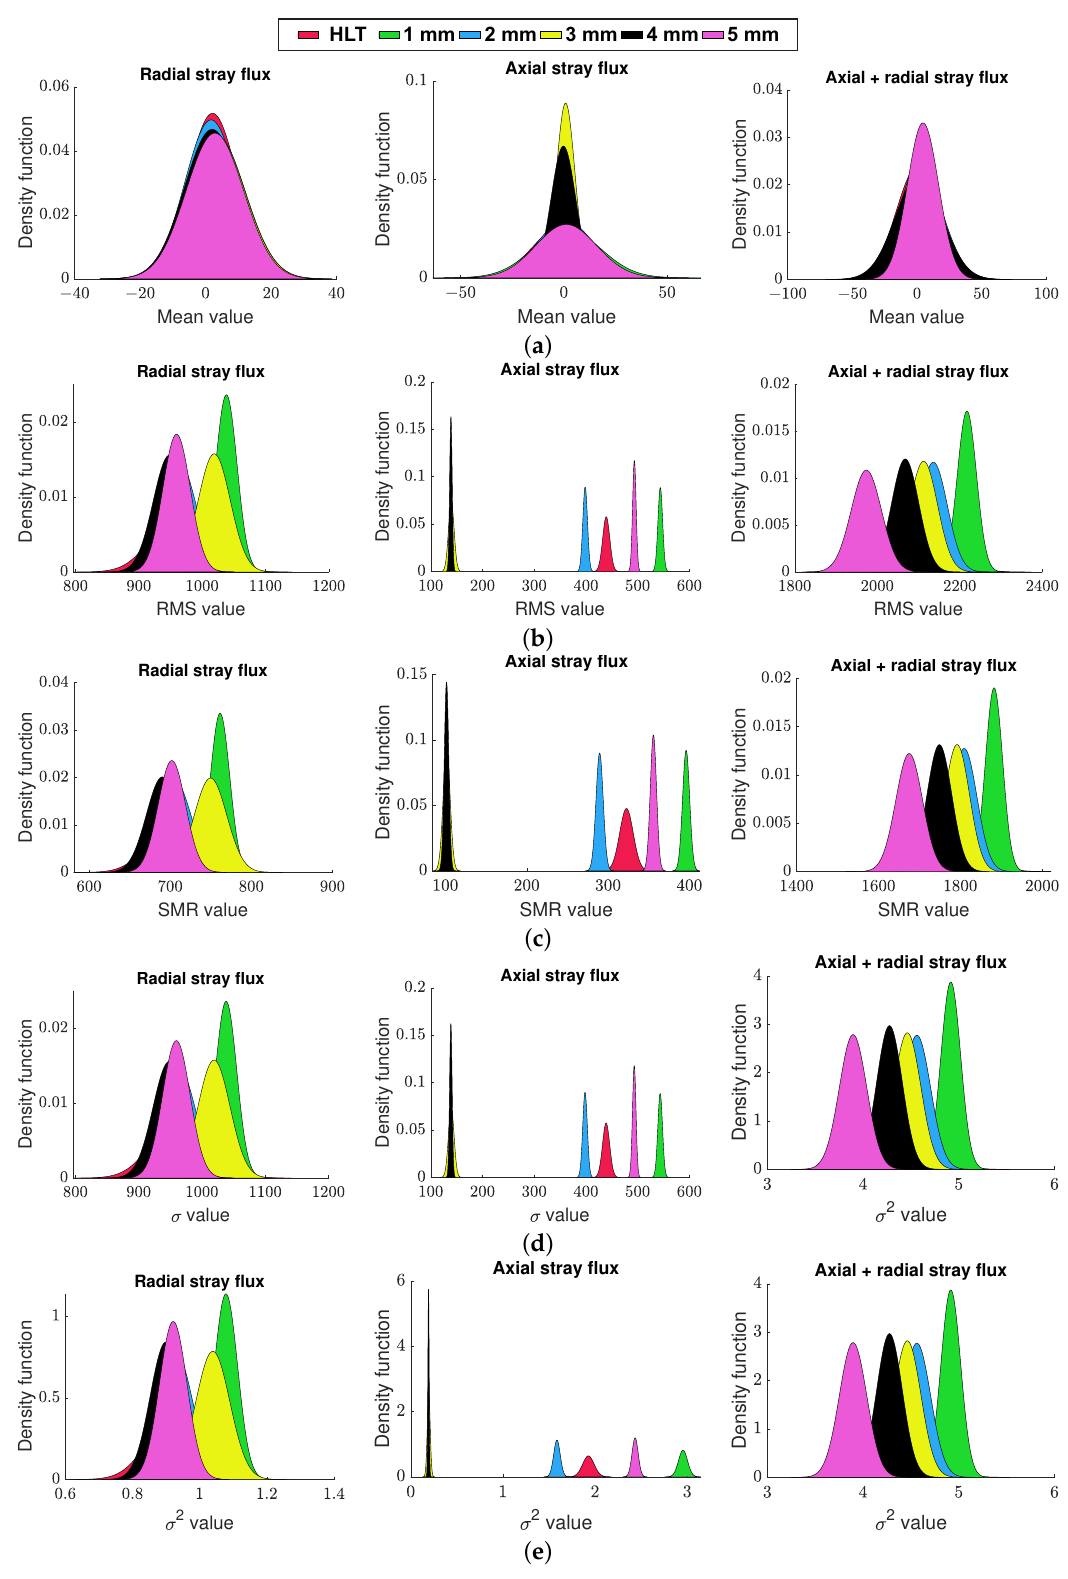
Figure 7. Normalized density functions defining detectability zones obtained by the different TF values from the different stray flux components using: ( a ) Mean value. ( b ) RMS value. ( c ) SMR value. ( d ) σ value. ( e ) σ 2